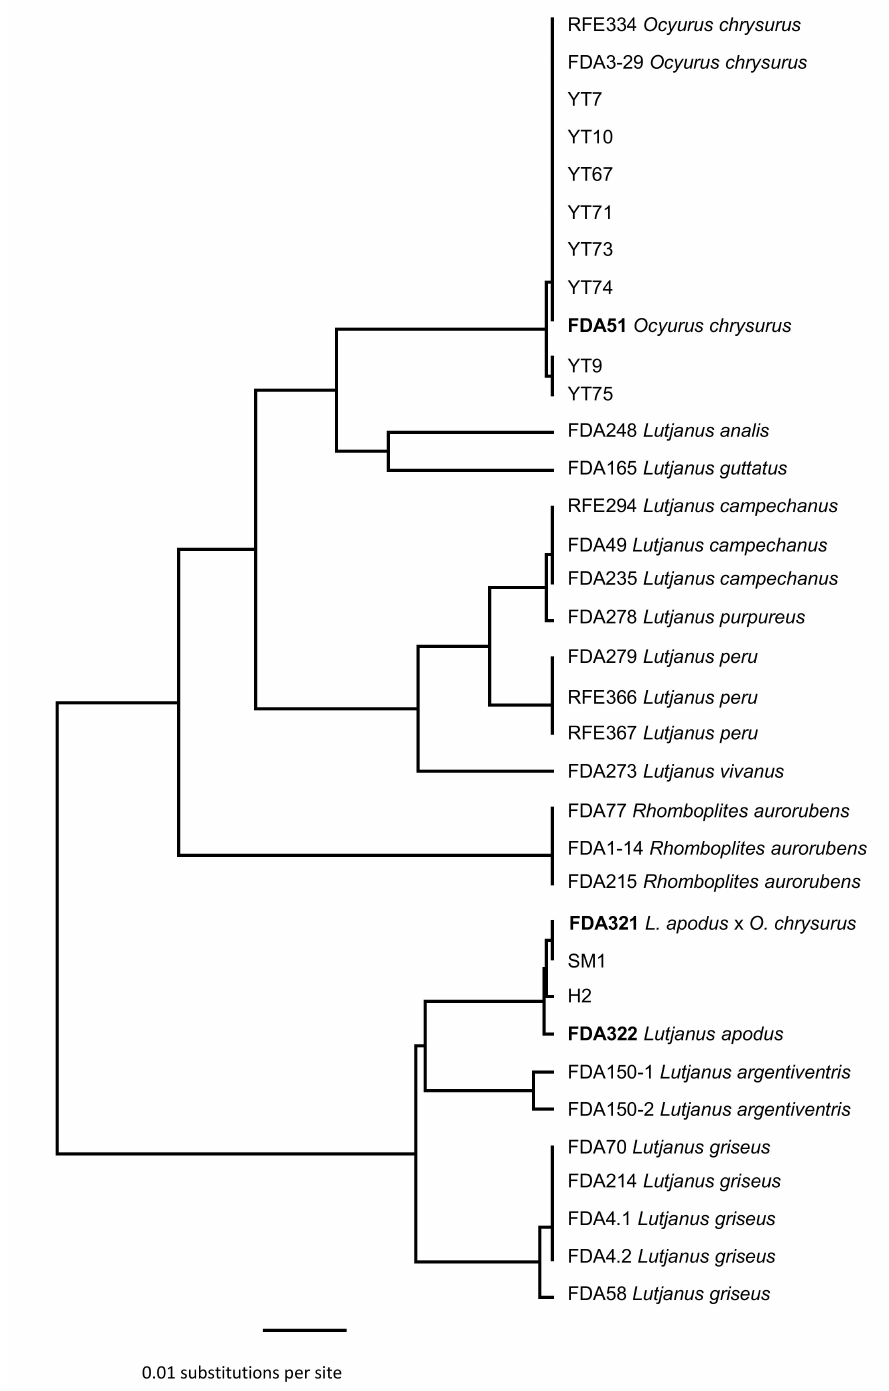
Figure 2. UPGMA (Unweighted Pair Group Method with Arithmetic Mean) tree based on DNA barcoding results (CO1). The results of CO1 sequences for hybrids will only indicate the mother and, for the individuals tested in this study, the sequences match the schoolmaster snapper genetically by 99.8%. FDA51, FDA321, and FDA322 pictured in Figure 1. YT = Yellow Tail Snapper, H = hybrid, SM = School Master Snapper, additional fish collected but not vouchered for this